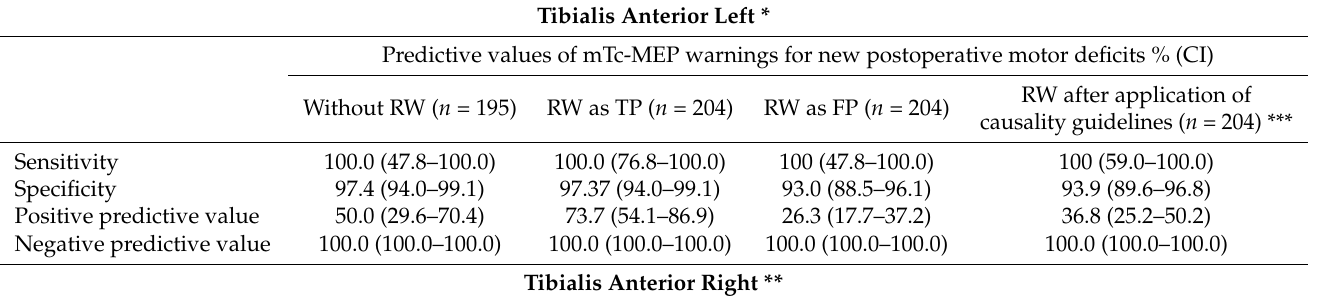
Table 6. Predictive values for the postoperative neurological outcome for the left TA and right TA separately. Tibialis Anterior Left